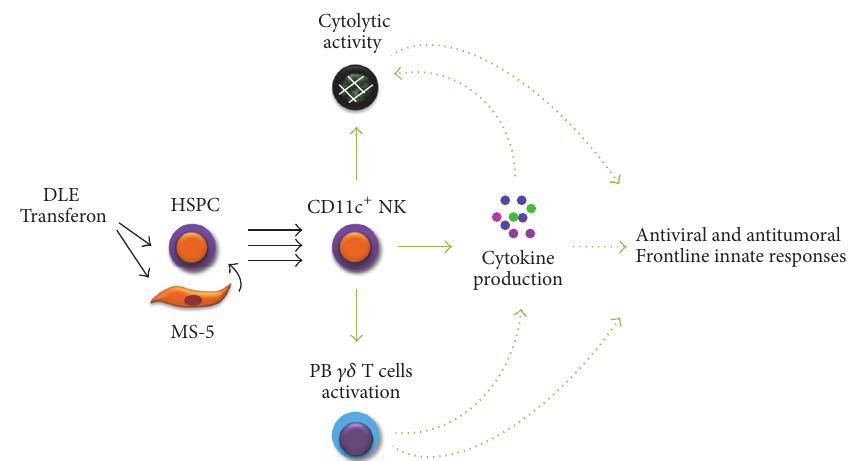
Figure 7: Emergent CD11c + NK cell production contributing the adjuvant immune-surveillance effects of DLE Transferon: a proposed model. Dialyzable leukocyte extracts Transferon promote the early differentiation of functional CD11c + NK cells endowed with the capabilities of tumor cell cytotoxicity, IFNy production, and 𝛾𝛿 T lymphocyte proliferation induction, which may in turn contribute to innate immune responses against virus-infected or tumor cells. The potential involved mechanisms require further